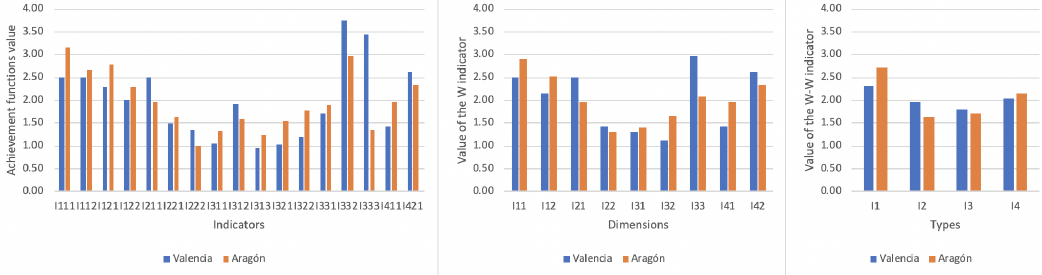
Figure 4. Values of the successive aggregations for (ES52) Comunidad Valenciana and (ES24) Aragón. We can see the values of the achievement functions of the single indicators ( left ), the weak composite indicator of each dimension ( center ) and the weak–weak composite indicator of each type ( right ). Table 2. Spain Regions’ innovation performance in 2019 relative to RII and MRP-WSCI: EU reference